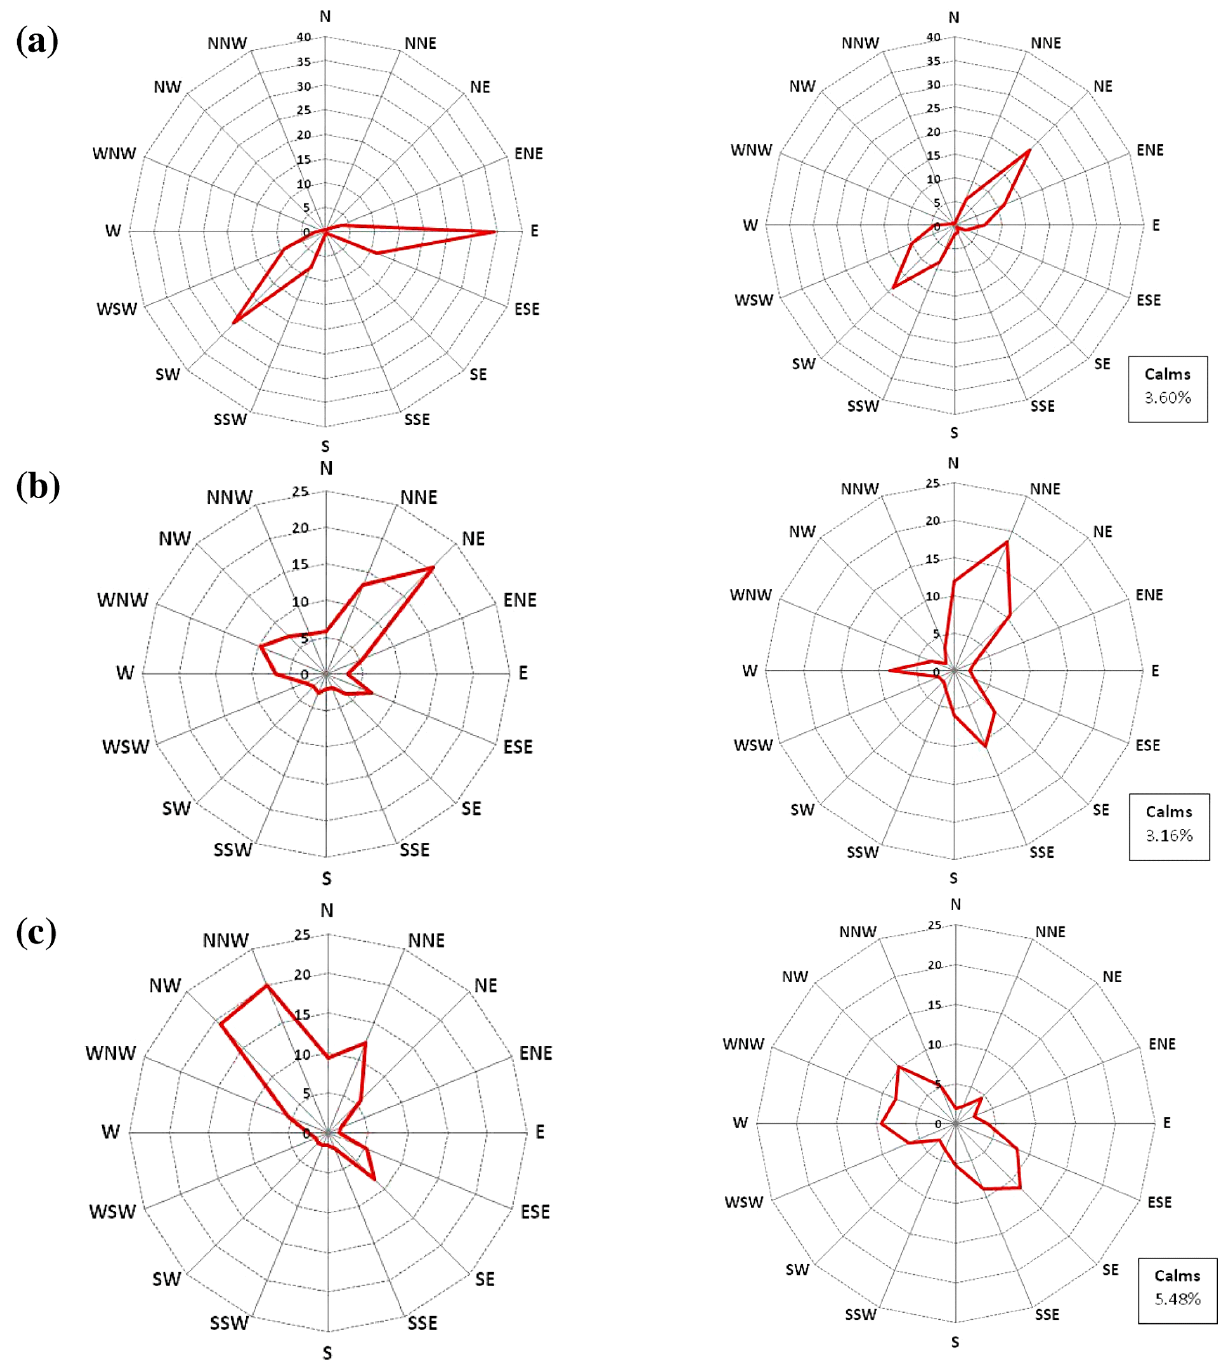
Fig. 5. Comparison between simulated (left column) and observed (right column) wind roses at ( a ) Rio, ( b ) Antikira, and ( c ) Isthmus of Corinthos. The wind data have been analyzed for the time period 2010–2011 of the available observations for Rio, Antikira, and Isthmus of Corinthos, respectively. The percentage of calm conditions for each ground station is also reported. Rings are drawn at 5 %